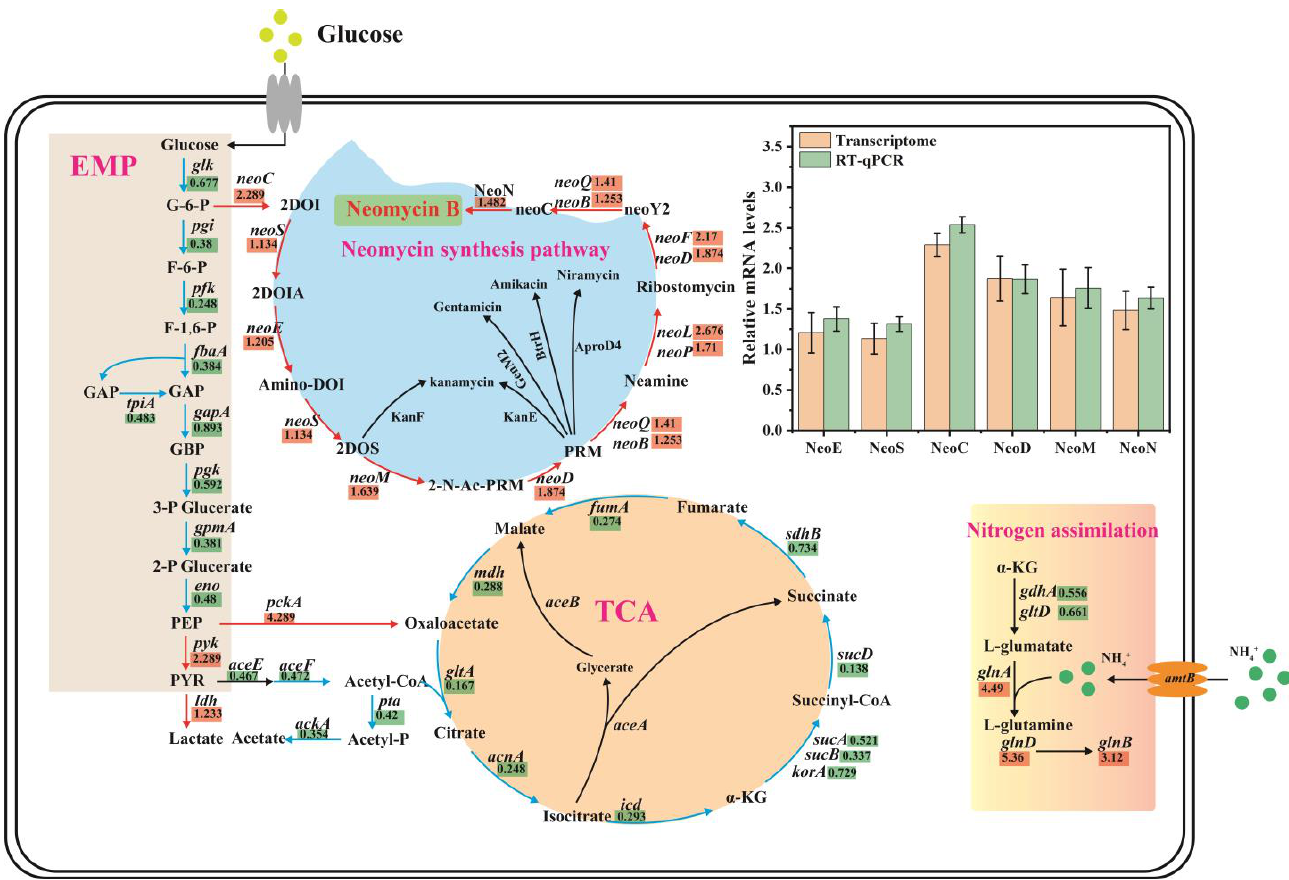
Figure 4. The expression levels of genes involved in neomycin B metabolism in S. fradiae SF-2 with 60 mM (NH 4 ) 2 SO 4 relative to 0 mM (NH 4 ) 2 SO 4 . The red arrows show genes whose expression levels are upregulated, and the green arrows show those whose expression levels are downregulated.